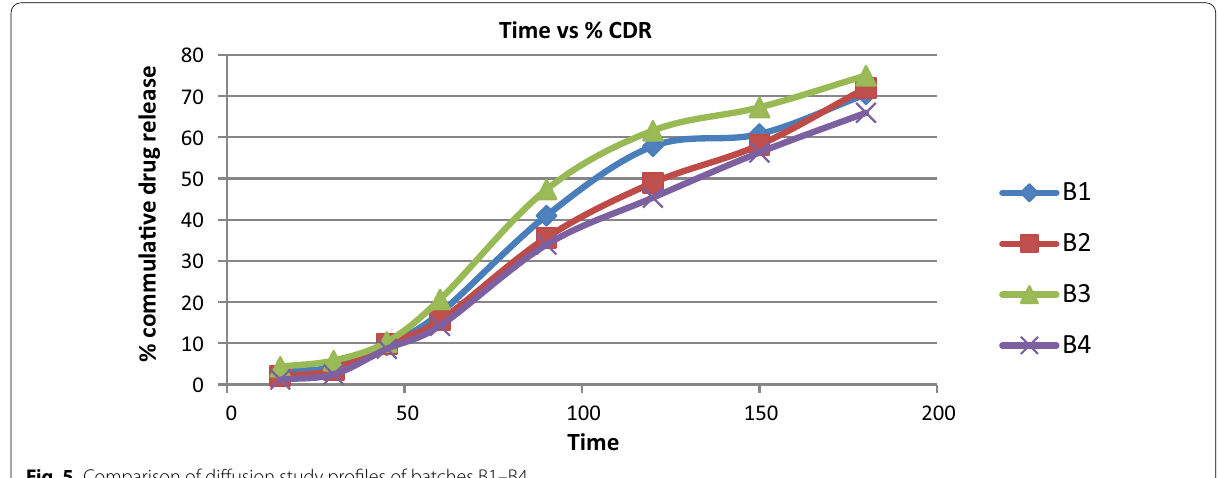
Fig. 5 Comparison of diffusion study profiles of batches B1–B4